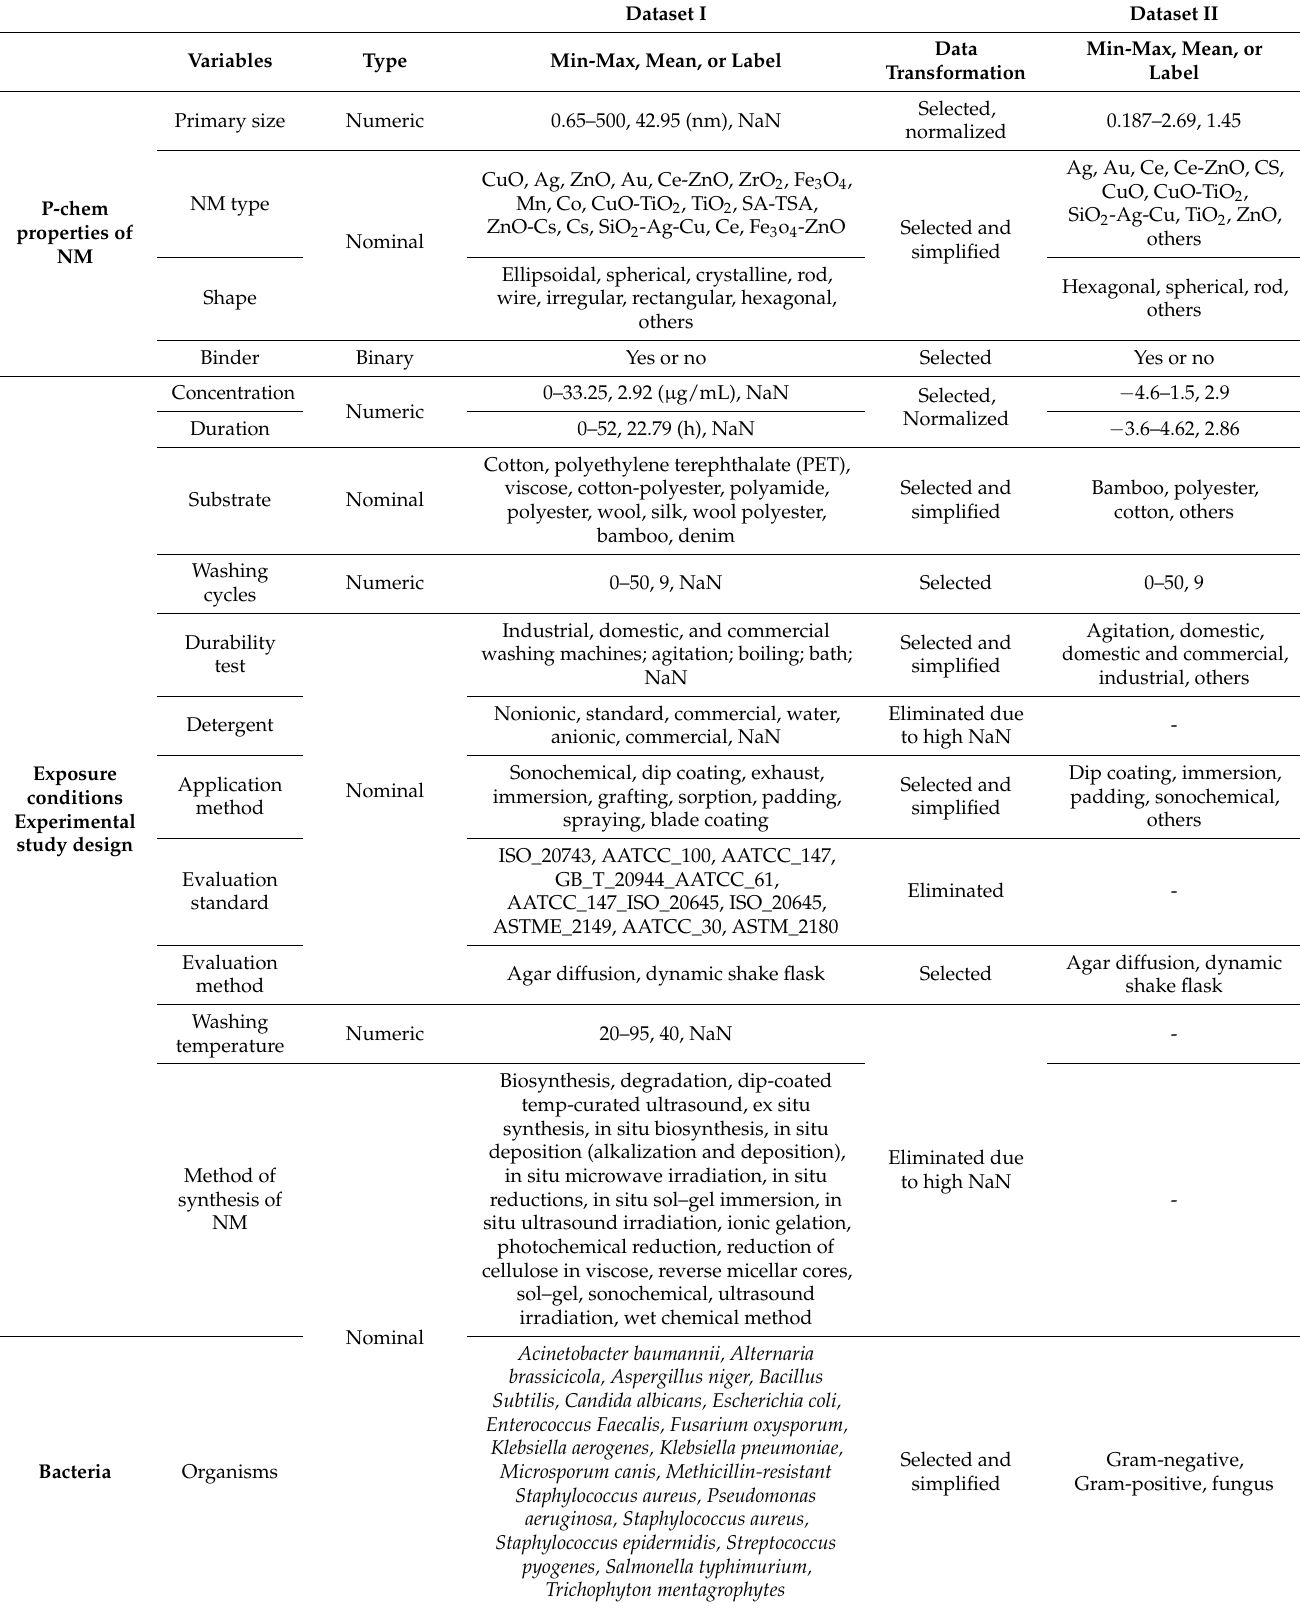
Table 1. The preliminary and final input variables in dataset I and dataset